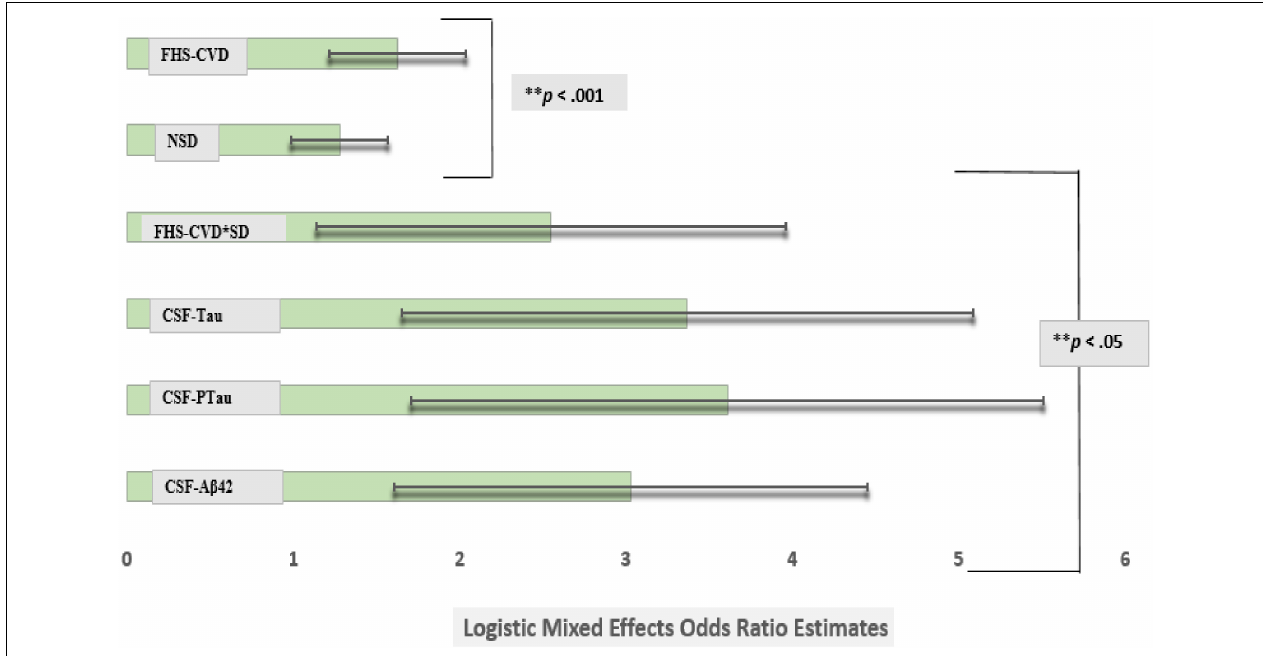
FIGURE 2 | Comparison of logistic mixed effects model estimates of CSF A β 42, CSF Tau, CSF PTau, SD, and vascular risk on the risk of conversion from cognitively normal to amnestic mild cognitive impairment (MCI). Sleep disturbance’s (SD) effect on an incident amnestic MCI diagnosis at a UDS follow-up was attenuated after adjusting for commonly used Alzheimer’s disease markers in the same model (model 3). However, the Framingham Heart Study-general cardiovascular disease (FHS-CVD) risk score and the interaction between SD and FHS-CVD risk score remained significantly associated with an incident MCI diagnosis at a uniform dataset (UDS) follow-up even after including these molecular biomarkers in the model. More importantly, the SD and FHS-CVD risk score synergism approximated the risk estimates of each molecular AD biomarker though significantly different. ∗∗ Multiple comparisons: FHS-CVD*SD vs. CSF-A β 42, FHS-CVD*SD vs. CSF-Tau and FHS-CVD*SD vs. CSF-PTau ( p < 0.01 for